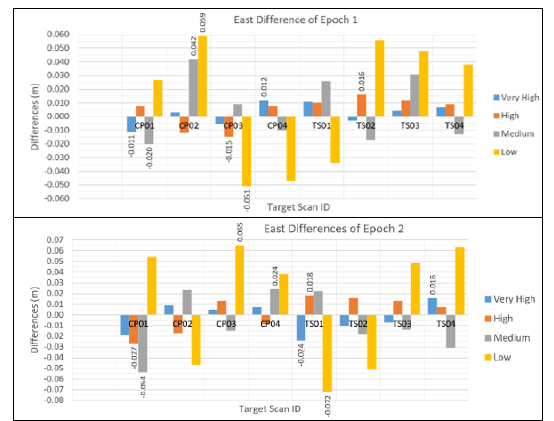
Figure 49. Easting coordinates differences between point cloud data by picking point manually and Total Station data using intersection method (epoch 1 and 2)